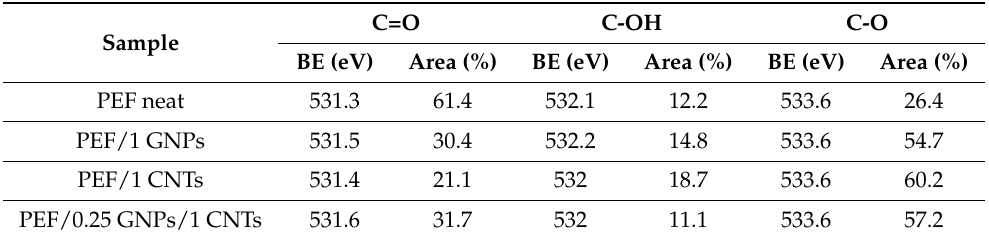
Table 6. Binding energies and % area of the oxygen bonds at the O1s spectra of neat PEF, PEF/1 GNPs, PEF/1 CNTs, and PEF/0.25 GNPs/1 CNTs.